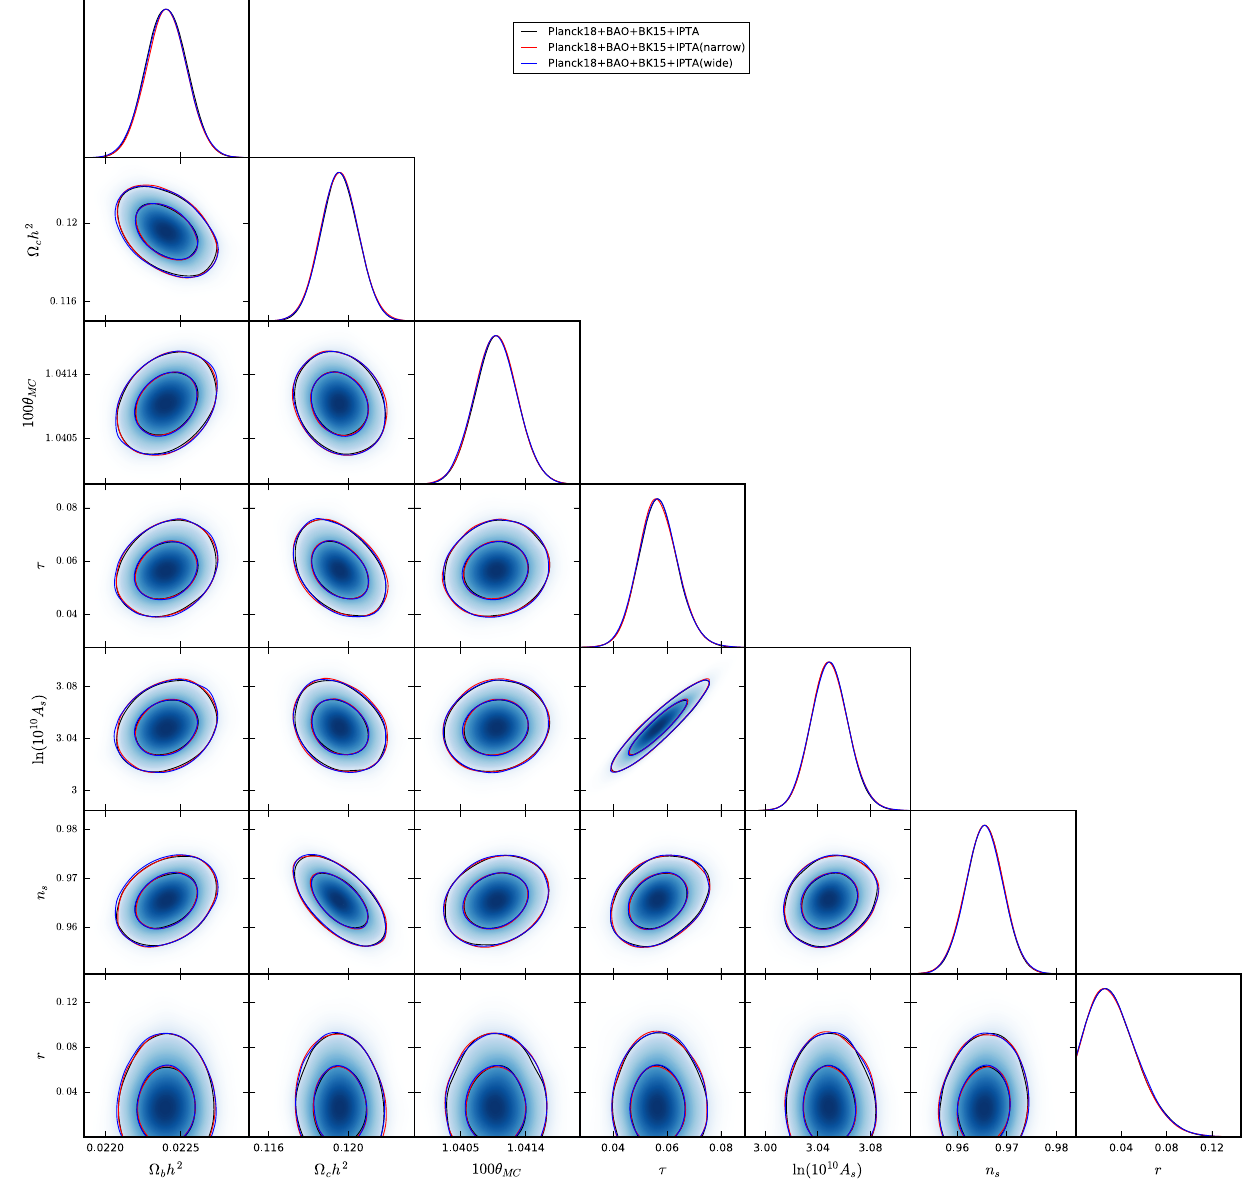
Fig. 3 The contour plots and the likelihood distributions for the cosmological parameters in the (cid:2) CDM+ r model at the 68% and 95% CL from the combinations of Planck18+BAO+BK15+IPTA, Planck18+BAO+BK15+IPTA n , Planck18+BAO+BK15+IPTA w ,